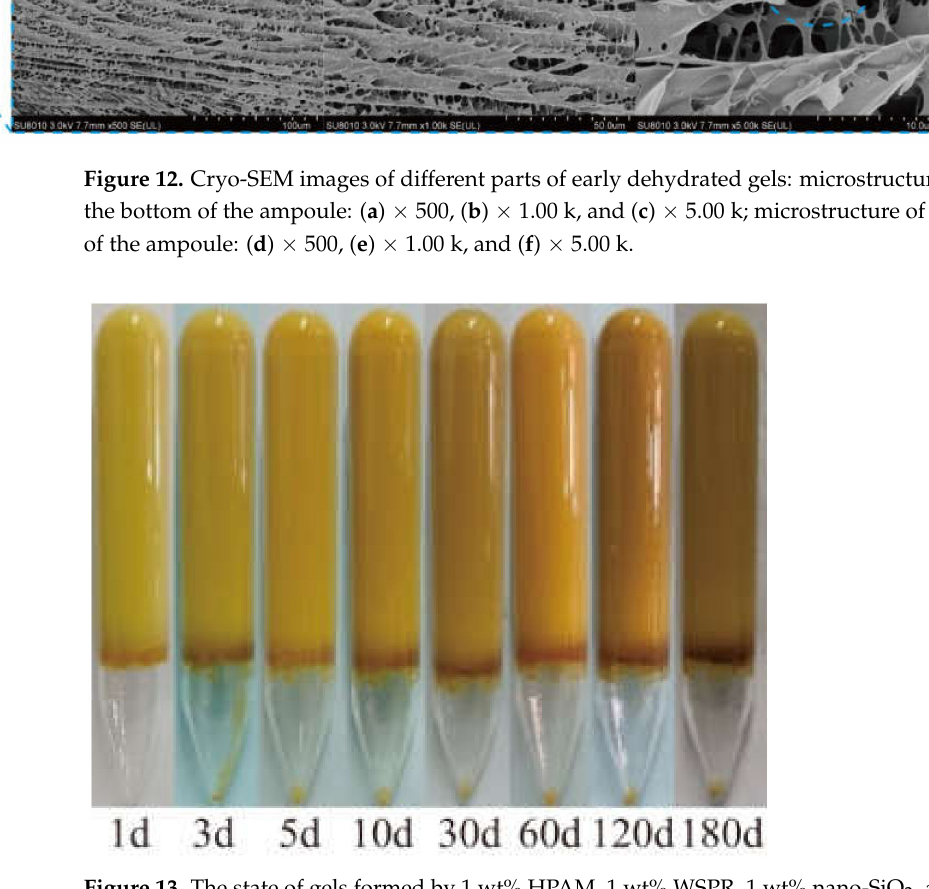
Figure 13. The state of gels formed by 1 wt% HPAM, 1 wt% WSPR, 1 wt% nano-SiO 2 , and 0.025 wt% HQ aged at 110 ◦ C for different